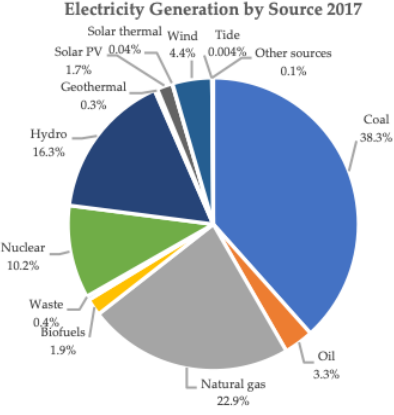
Figure 5. Electricity Generation by Source 2017 (Source: IEA).